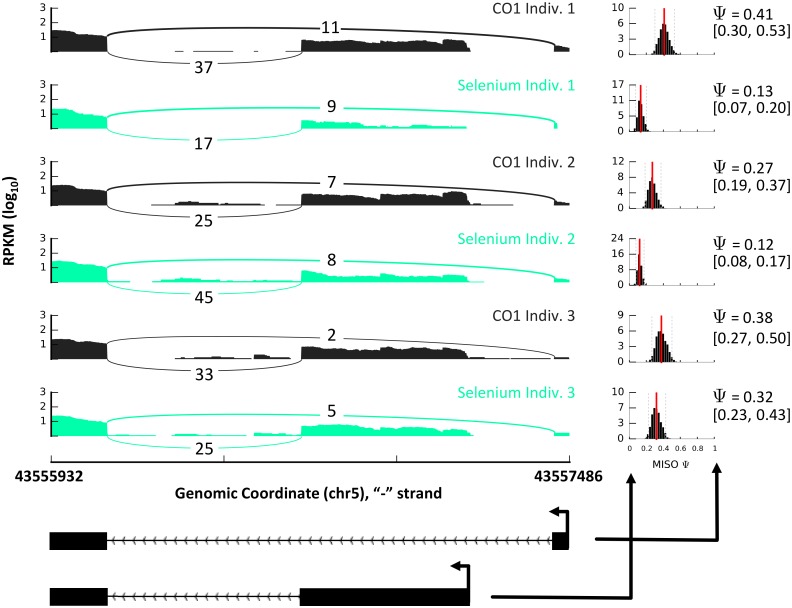
Sashimi plot showing AFE change following selenium treatment in LCLs across 3 unrelated individuals.The diagrams on the left show the read coverage of an AFE shift in PAIP1 for six samples (three selenium and three control treated LCLs). The plots on the right show the full posterior distribution of the Ψ value, along with their confidence intervals. The model of this region is represented below. High Ψ (greater than 0.5) indicates preference for the upstream AFE.